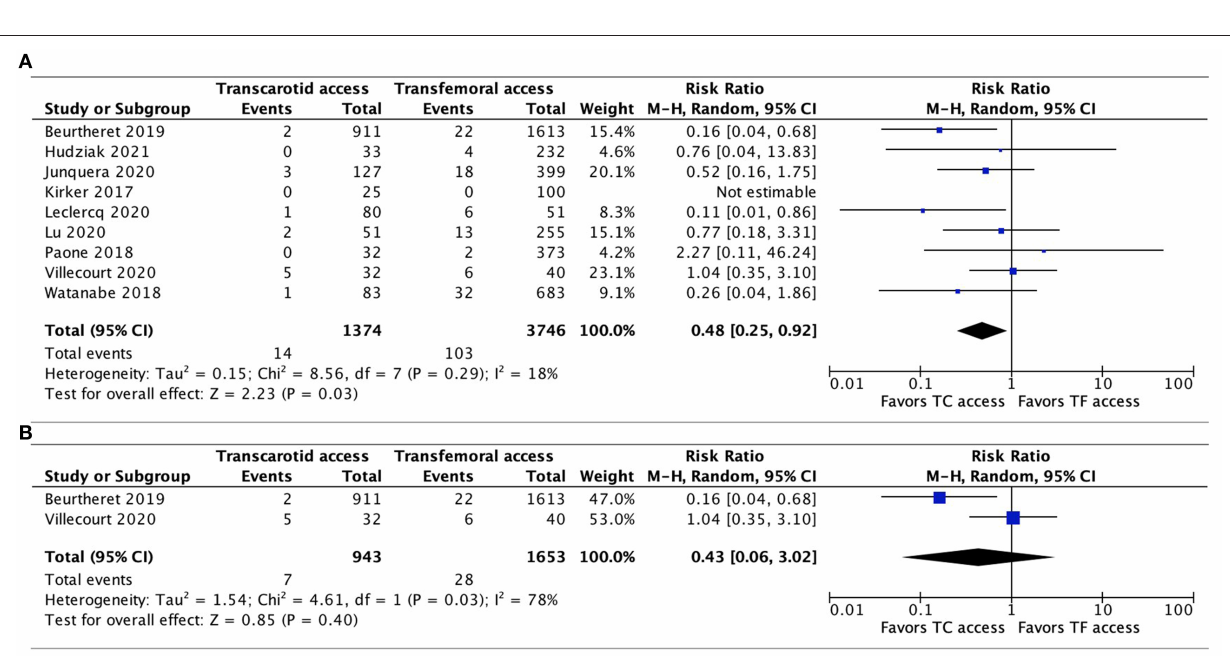
FIGURE 4 | Forest plots comparing major vascular complications between TC and TF transcatheter aortic valve replacement procedures. (A) Pooled data from all studies. (B) Pooled data from propensity-score matched studies. TC, transcarotid; TF,